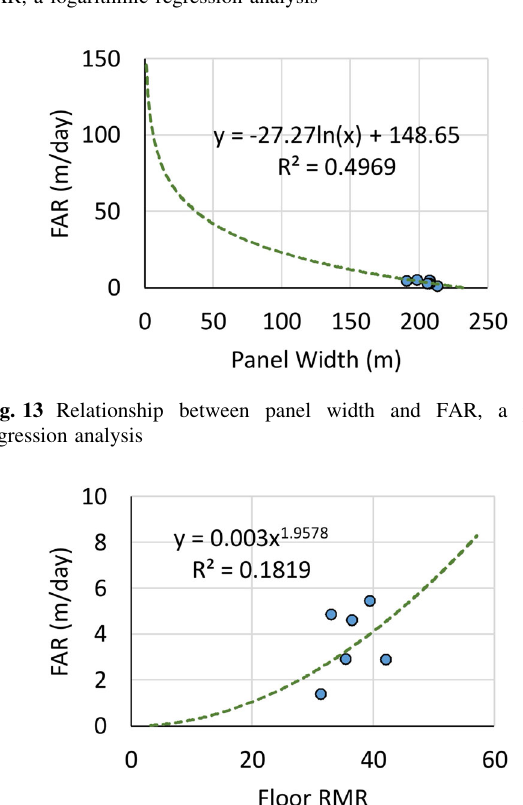
Fig. 12 Relationship between longwall face inclination of face and FAR, a logarithmic regression analysis